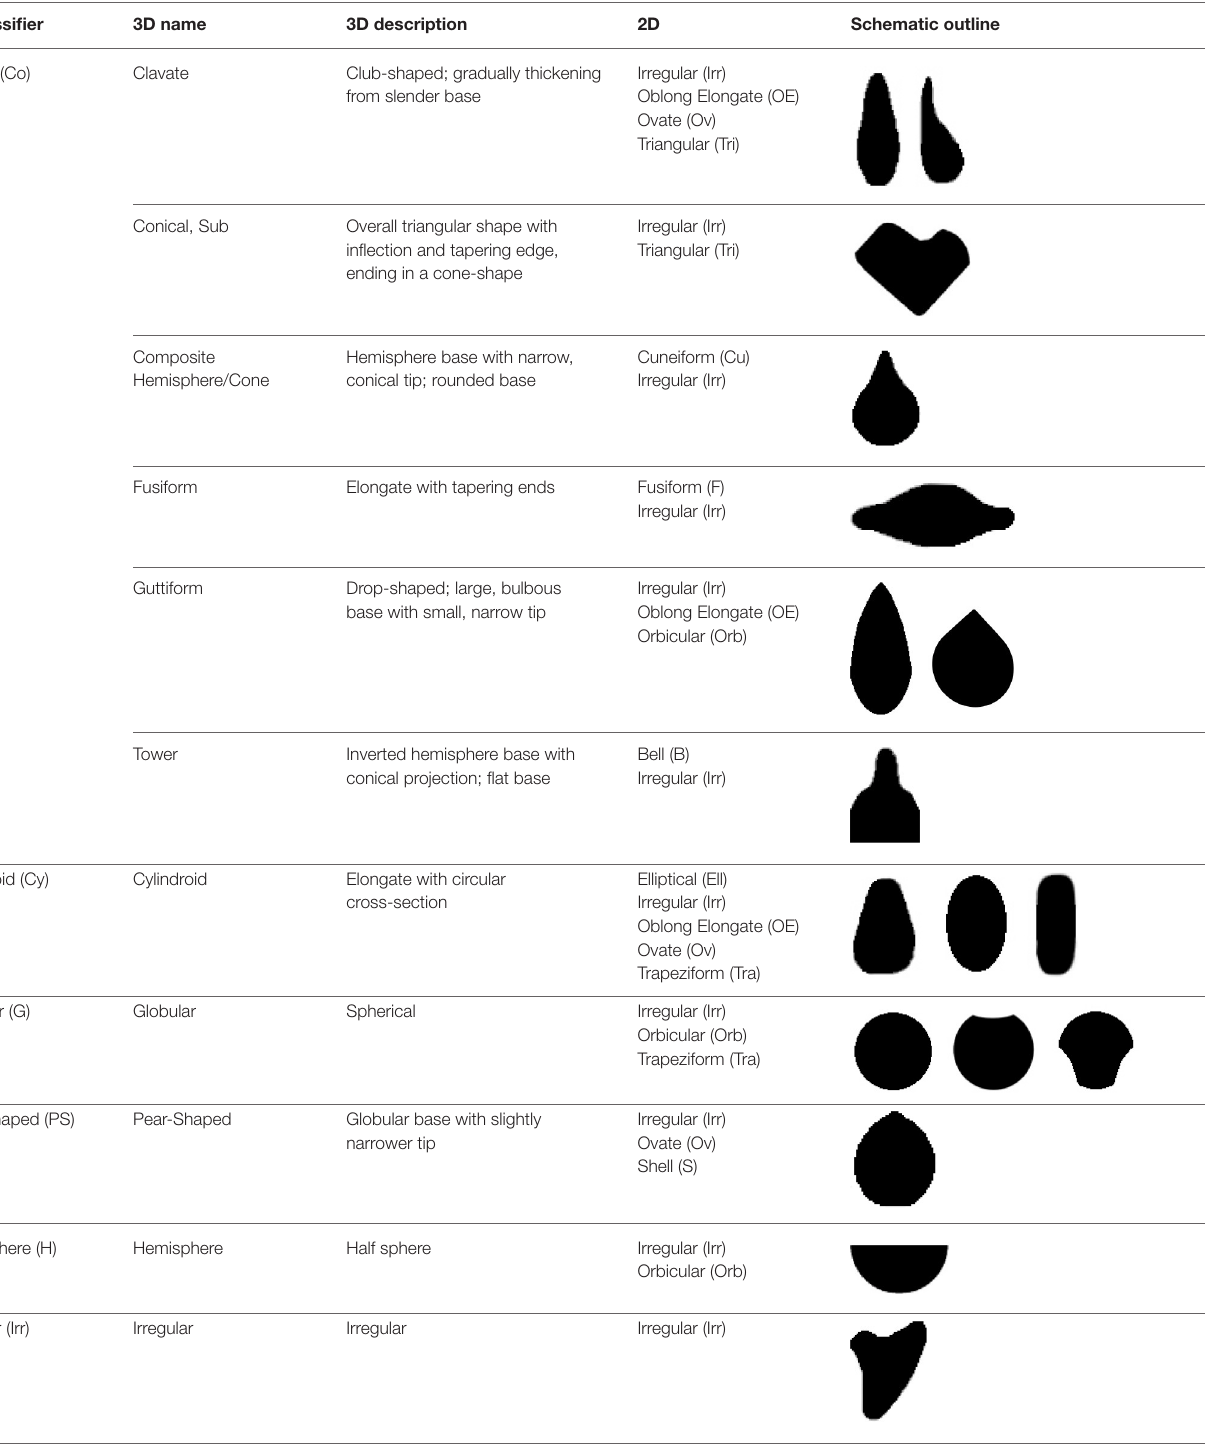
TABLE 2 | Starch granule